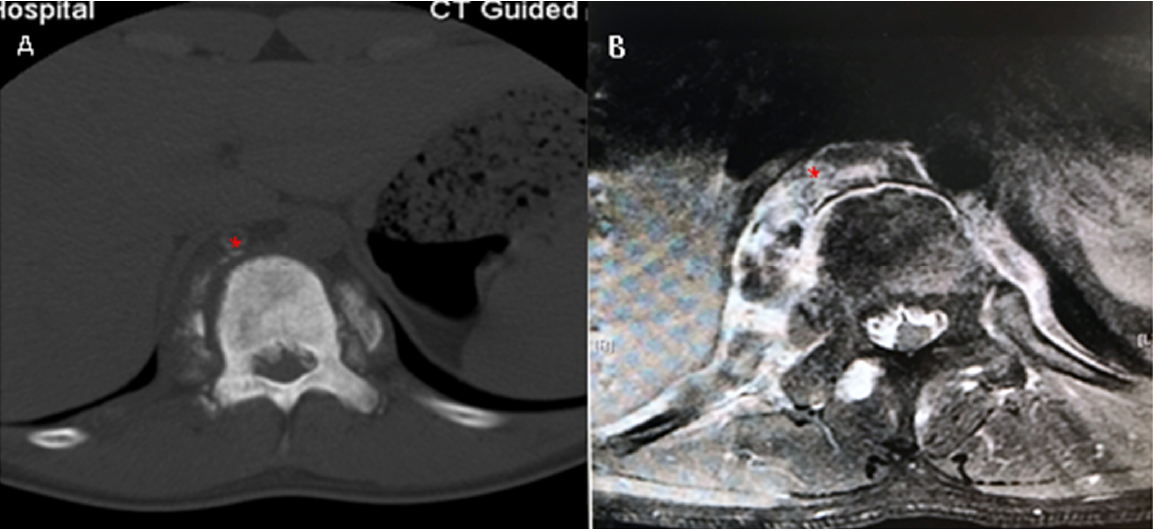
Figure 3. The azygos vein (* in red) was occupied by tumor-like tissues ( A ), and the tissues were significantly enhanced in MRI T1-weighted imaging ( B ).